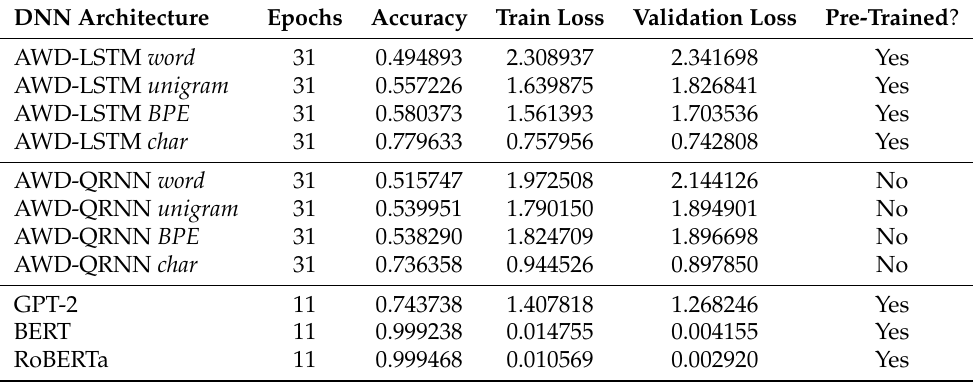
Table 1. Results after full training of each NN architecture. AWD, Average Stochastic